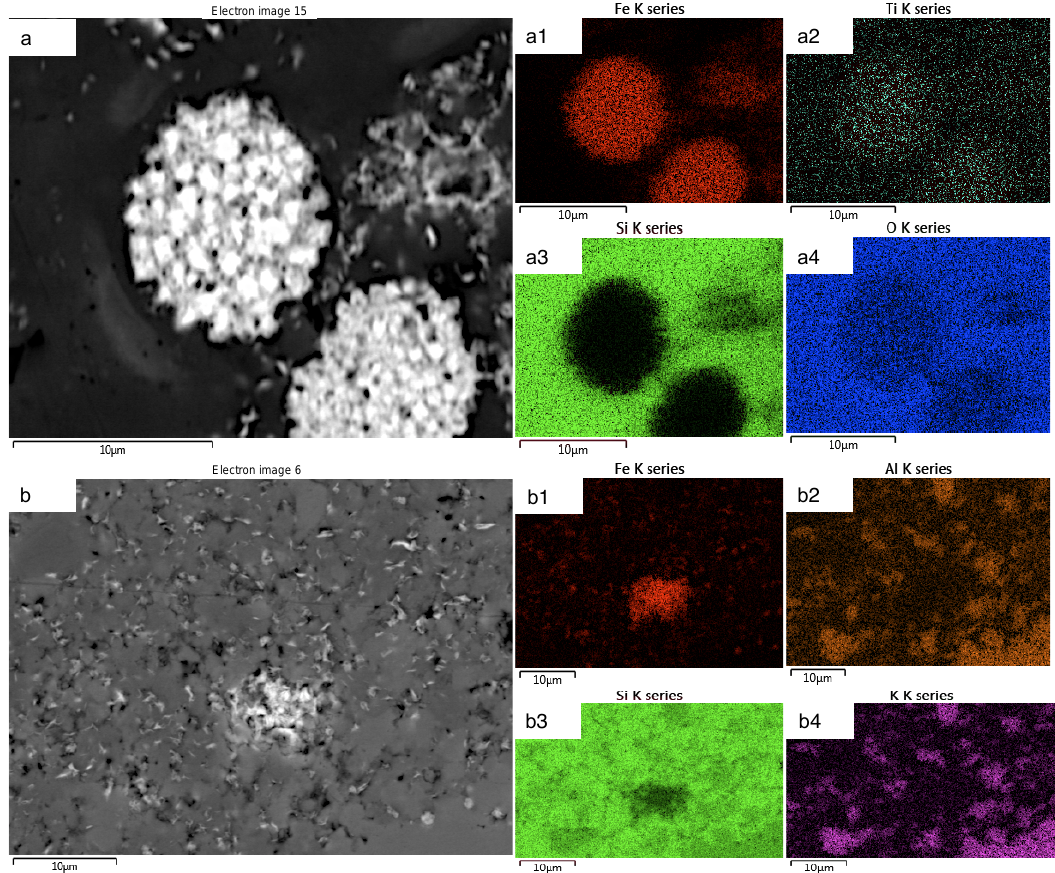
Figure 3. EDS electron micrograph showing Fe-rich mineral phases in a Si-rich matrix from the MFIF. The bright colors correspond to the analyzed elements: (a) framboidal hematite particles ( a1 – a4 , elemental compositions of the framboidal particles in a ); (b) dispersed fluffy Fe-rich mineral grains ( b1 – b4 , corresponding elements associated with the micrograph in panel a ).